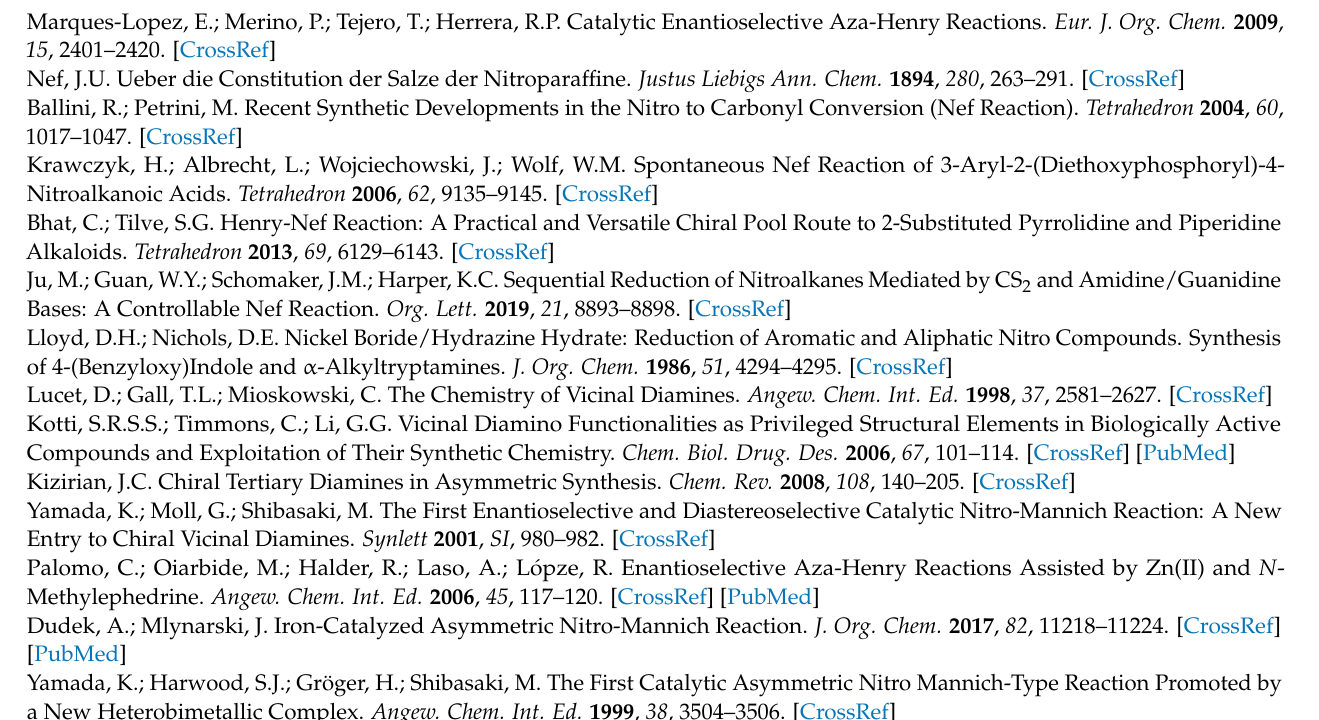
points represent BCPs, and the solid and dashed lines represent the areas with positive and negative Laplacian of electron density, respectively; Figure S2: Selected bond critical points with corresponding Laplacian ( ∇ 2 ρ ) and electronic density ( ρ ) values for four transition states G1-I- re -TS2 ~ G1-II- si -TS2 by AIM analysis; Figure S3: Schematic molecular orbital interaction diagram for transition state G1-I- re -TS2, constructed by G1-R2 (Frag. 1) and N -Boc ketimine (Frag. 2) fragments obtained with the ADF program; Figure S4: Schematic molecular orbital interaction diagram for transition state G1-I- si -TS2, constructed by G1-R2 (Frag.1) and N -Boc ketimine (Frag. 2) fragments obtained with the ADF program; Figure S5: Optimized geometries of transition states G1-I- re -TS2-a ~ G1-II- si -TS2-a. Relative Gibbs free energies are given in kcal · mol − 1 ; Figure S6: Relaxed potential energy scan of guanidine cation, calculated by scanning the dihedral angle N5-C1-N2-Cy (a) and N5-C1-N3-Cy (b) at M06-2X-D3/6-31G(d,p)(SMD, toluene) theoretical level; Figure S7: Noncovalent interaction (NCI) plots near bulky CPh 3 group areas for G1-I- re -TS2 ~ G1-II- si -TS2. Strong and attractive interactions are blue, weak interactions are green, and strong and repulsive interactions are red; Figure S8: Energy profiles for aza-Henry reaction between N -COOEt ketimine (R1b) and nitromethane (R2) catalyzed by guanidine (G1) along re -face and si -face pathways in model I; Figure S9: Energy profiles for aza-Henry reaction between N -Boc ketimine (R1a) and nitromethane (R2) catalyzed by guanidine (G2) along re -face and si -face pathways in model